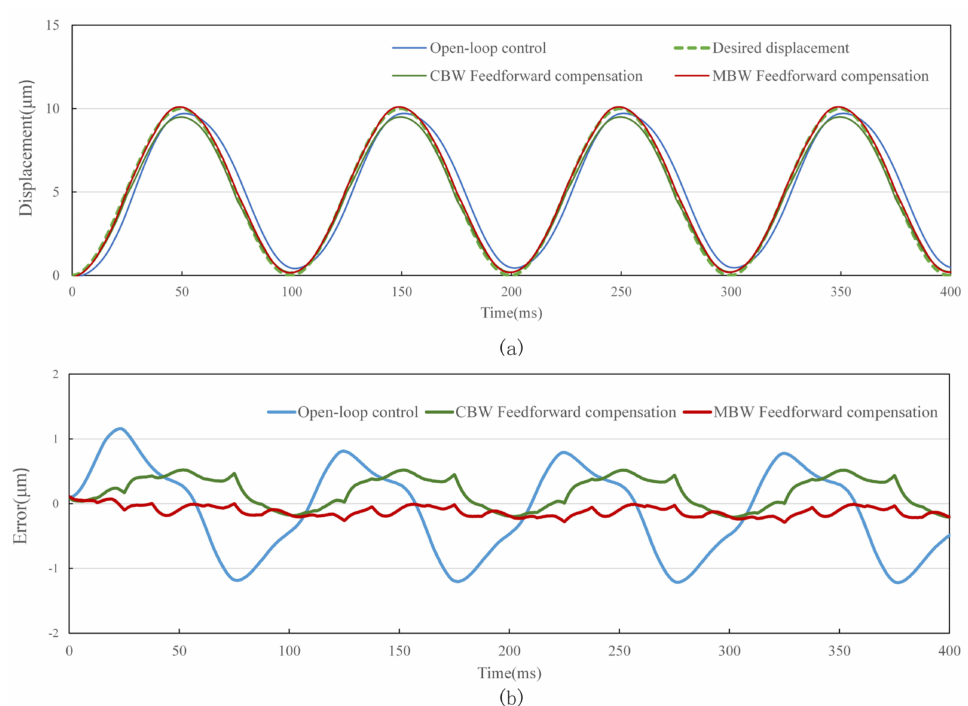
Figure 15. Standard sinusoid signal tracking performance with different control method at 10 Hz.